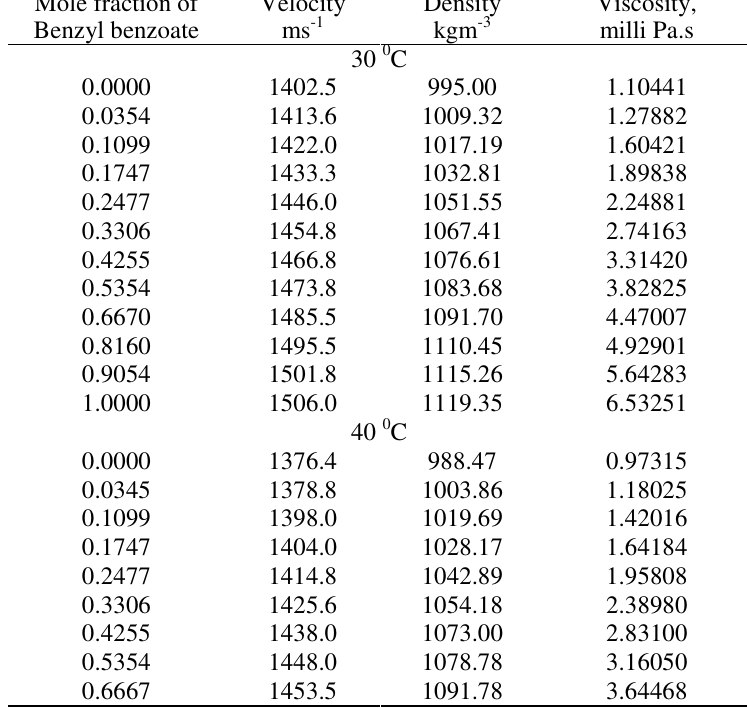
Table 3. Ultrasonic velocities, densities and viscosities for the system benzyl benzoate